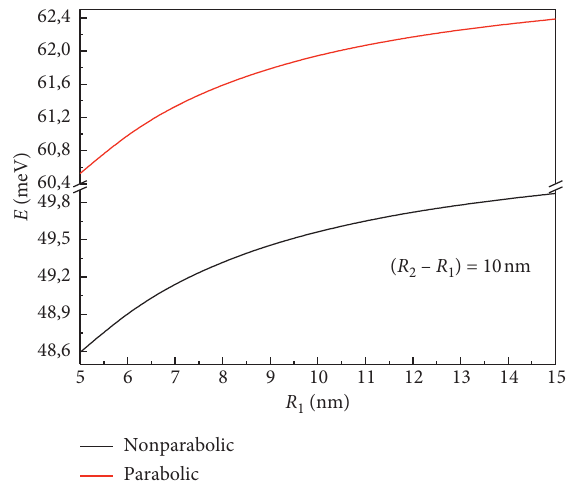
Figure 15: The dependence of the particle energy on the inner radius with a constant layer thickness of a cylindrical quantum nanorod and with a finite